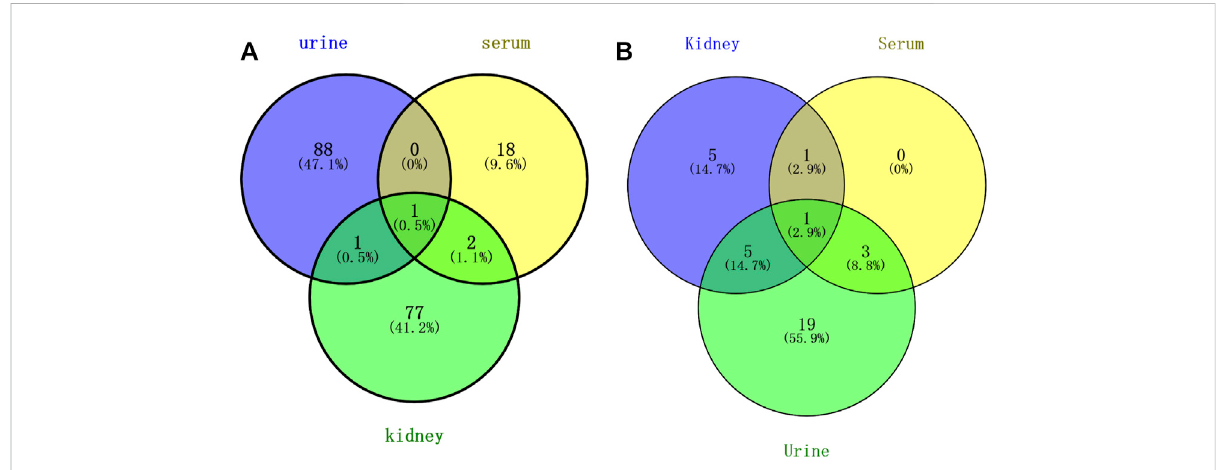
FIGURE 7 Venn analysis of potential biomarkers (A) and pathways (B) in rat urine, serum, and